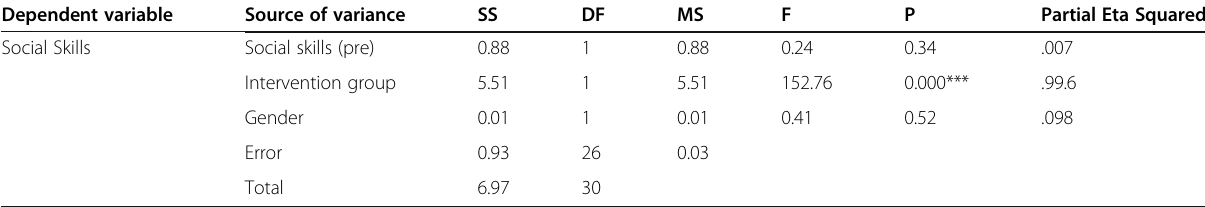
Table 4 ANCOVA test for social skills due to study variables Dependent variable Source of